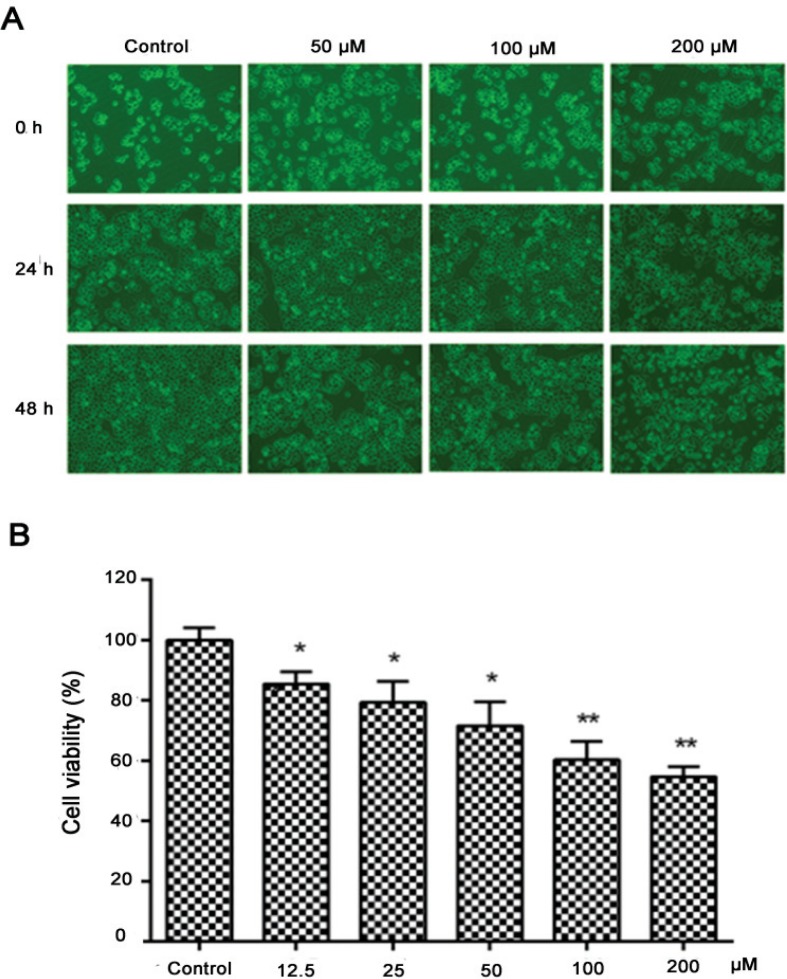
Effects of nobiletin on cell morphology and viability of MCF-7 cells. (A) MCF-7 cells were cultured with various concentrations (50, 100, and 200 μM) of nobiletin for 24 and 48 h and the images were obtained (10×). (B) Cell viability was determined by MTT assay. Compared with the control group, the survival rate of the cells in the dosage group after treatment was higher. Data are expressed as means ± SD from three independent experiments. *p < 0.05 compared with their respective control cells. **p < 0.01 compared with their respective control cells.